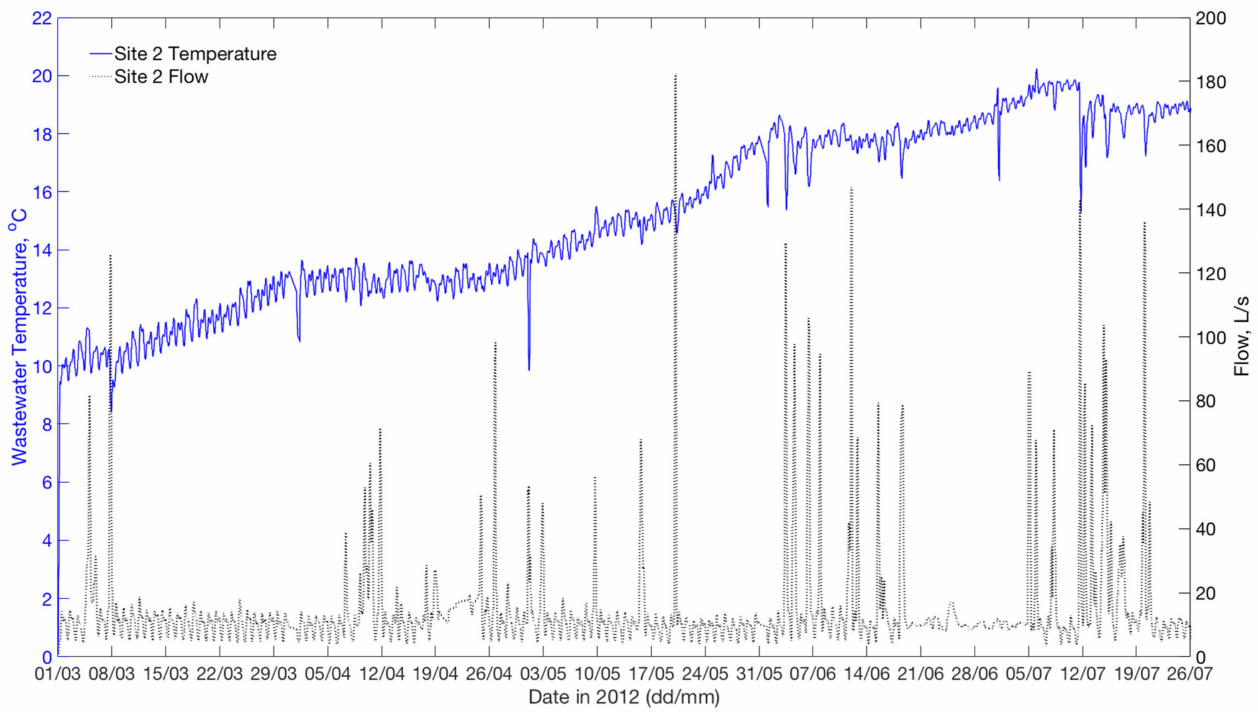
Figure 2. Observed wastewater temperatures and flow rates for site 2 (used for validating the residential sewer